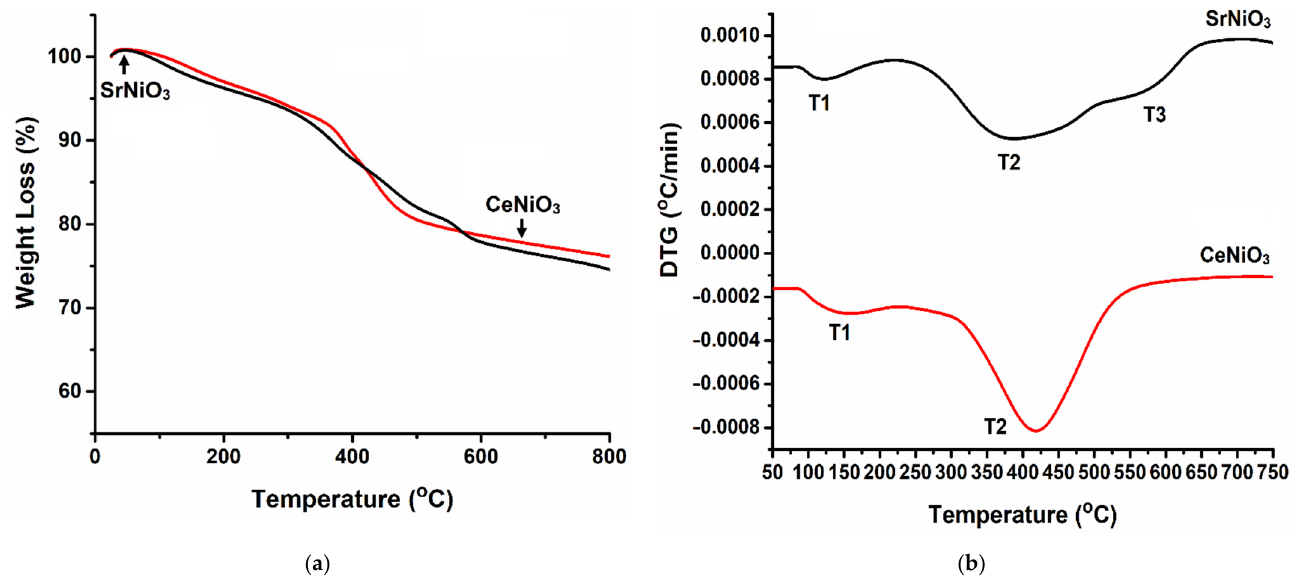
Figure 1. TG-DTG curves versus temperature of SrNiO 3 and CeNiO 3 perovskites.